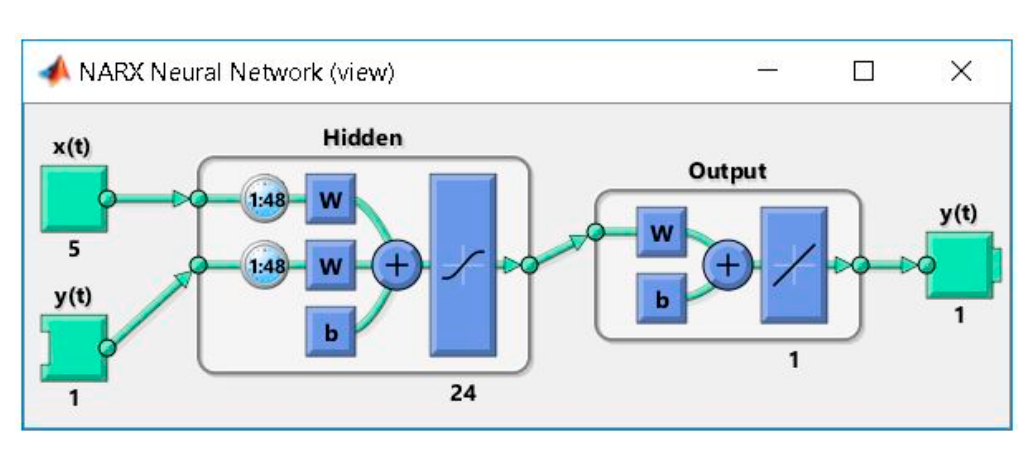
Figure 9. The ANN_NARX_BR_ALL’s architecture.